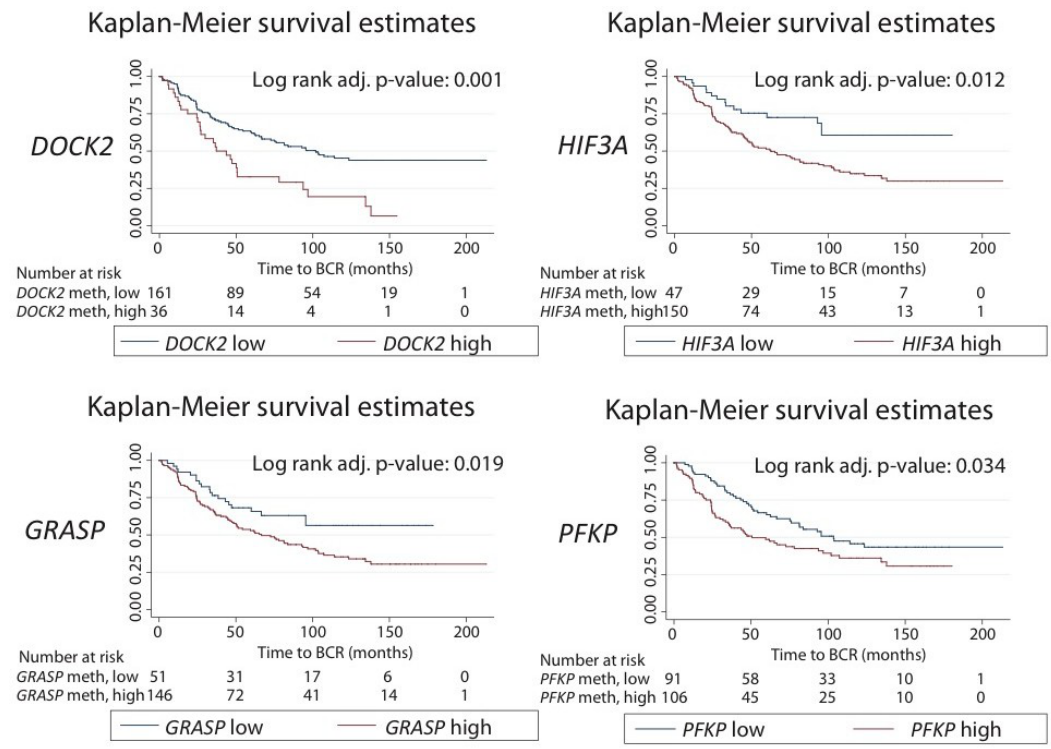
Figure 6. Kaplan–Meier plots with biochemical recurrence (BCR) as an endpoint in the Danish RP cohort. For each marker candidate, the patients were divided into low and high methylation subgroups based on the ROC curve analysis of the BCR status at the 36 months follow-up after RP. p -value from the log-rank test.